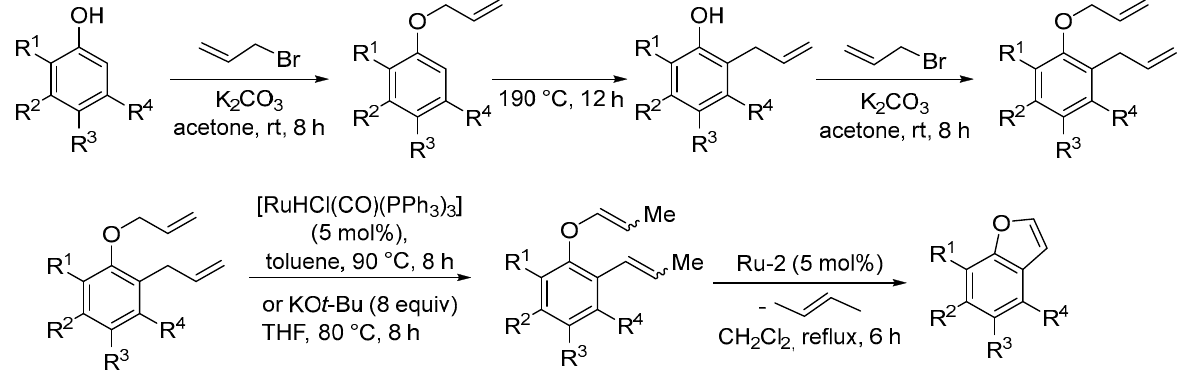
isomerization and RCM sequence.